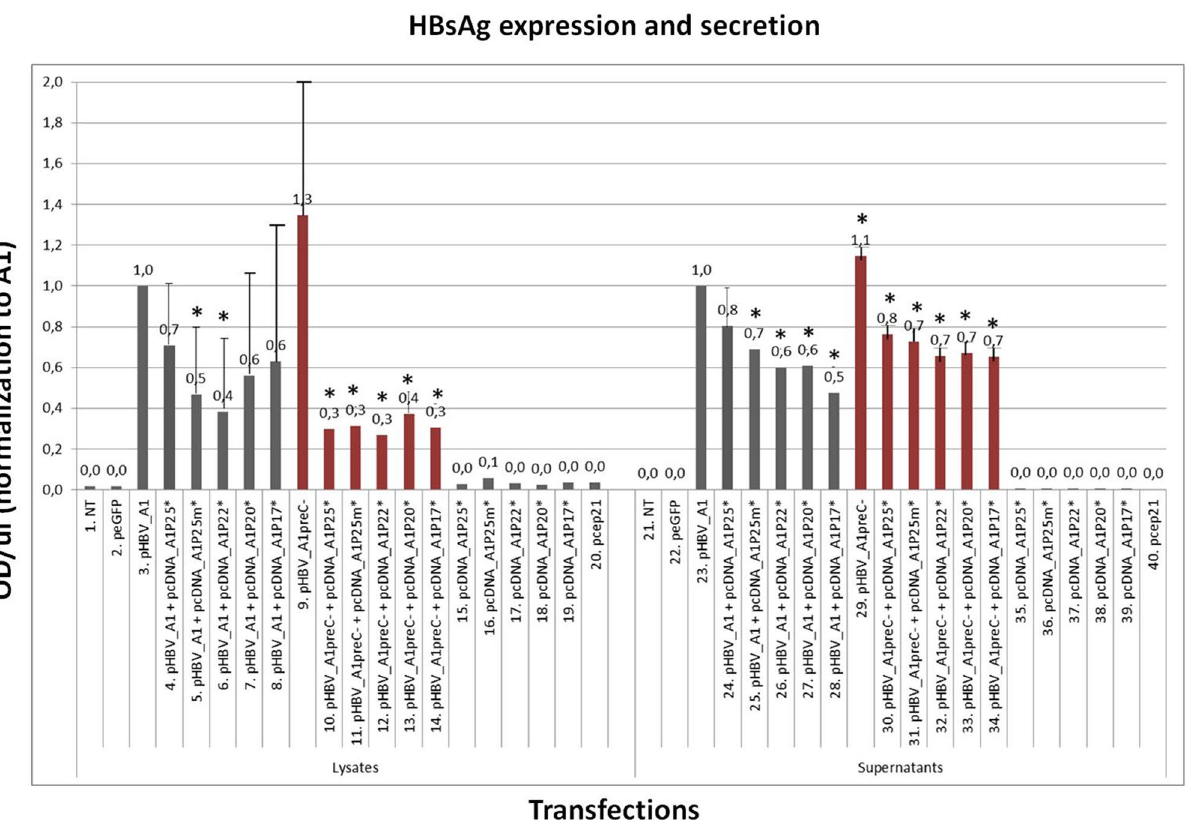
Figure 7. Effect of HBeAg and precursors on HBsAg expression and secretion. ( A ) Co-transfections of the subgenomic plasmids with pHBV_A1. HBV A1 replication competent clone (pHBV_A1) and A1 clone with knock-out of preC (pHBV_A1preC-) were transfected in HuH-7 cells. Cells were also co-transfected with pHBV_A1 and each of the plasmids pcDNA_A1P25*, pcDNA_A1P25m*, pcDNA_A1P22*, pcDNA_A1P20* or pcDNA_A1P17*. 3 days post-transfection, lysates and supernatants of cells were collected and subjected to anti- HBsAg ELISA. Results were normalized to pHBV_A1 for supernatants and for lysates. ( B ) Co-transfections of the subgenomic plasmids with pHBV_A1preC-. HuH-7 cells were co-transfected with pHBV_A1preC- and each of the plasmids pcDNA_A1P25*, pcDNA_A1P25m*, pcDNA_A1P22*, pcDNA_A1P20* or pcDNA_A1P17*. 3 days post-transfection, lysates and supernatants of cells were collected and subject to anti-HBsAg ELISA. Results were normalized to pHBV_A1preC- for supernatants and for lysates. (*) above each column indicates significant differences with pHBV_A1. Result of average of 4 independent experiments. NT non-transfected